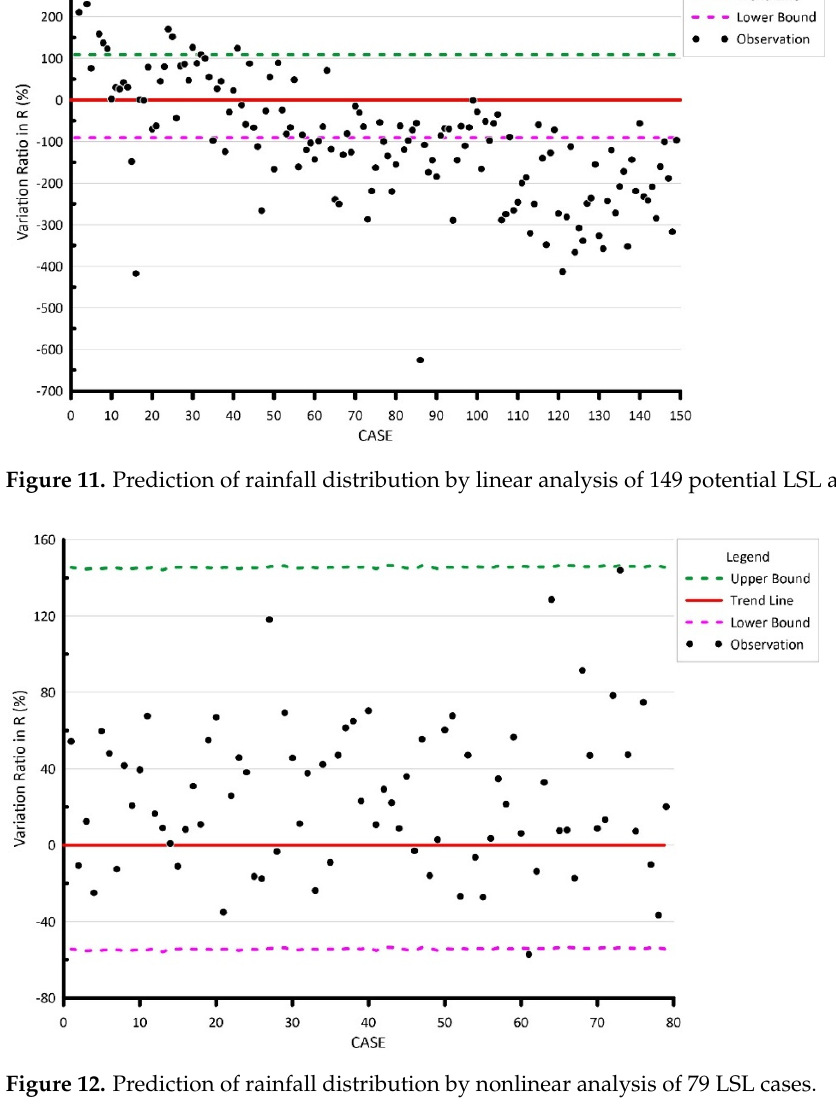
Figure 12. Prediction of rainfall distribution by nonlinear analysis of 79 LSL